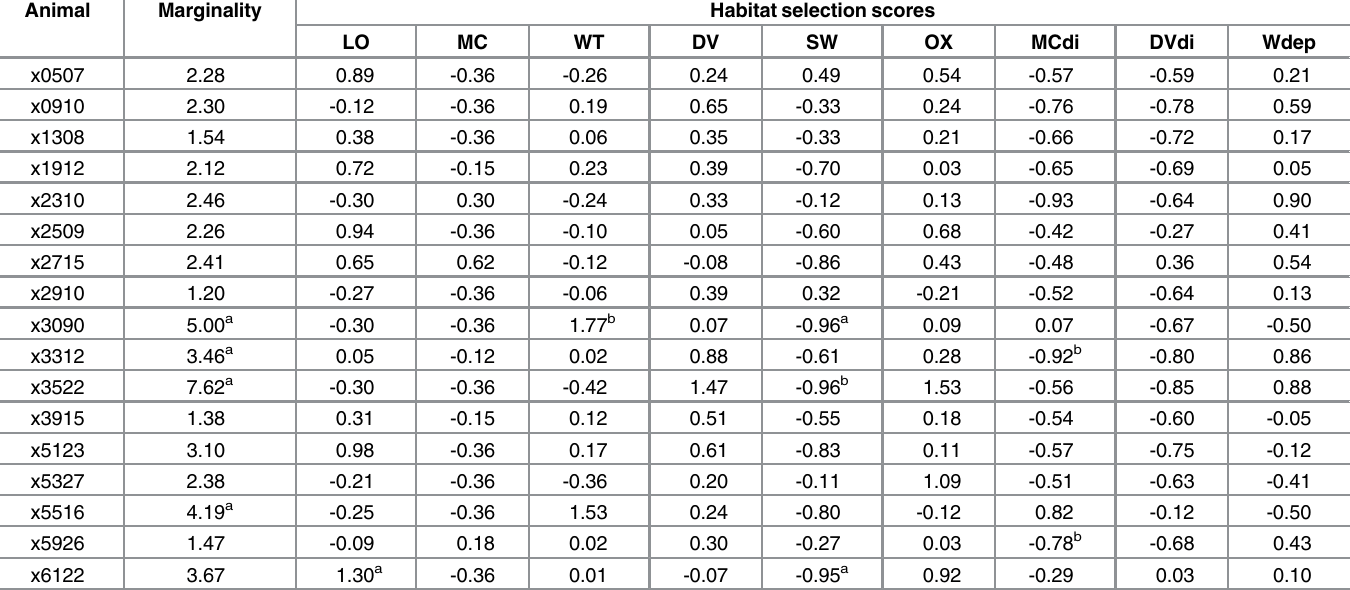
Table 1. Home range selection marginality values of radio-tracked adult male alligators at Ross Barnett Reservoir and Pearl River, Mississippi, USA, 2012 – 2013. Animal Marginality Habitat selection